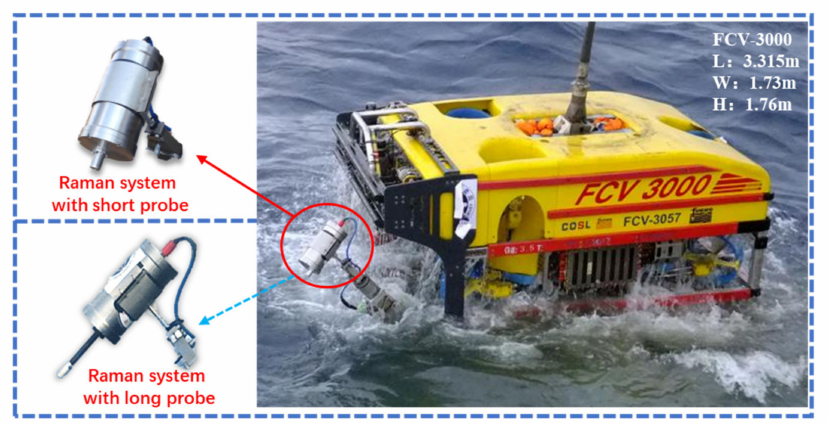
Figure 1. The system deployed on the 3000m class ROV for deep-sea